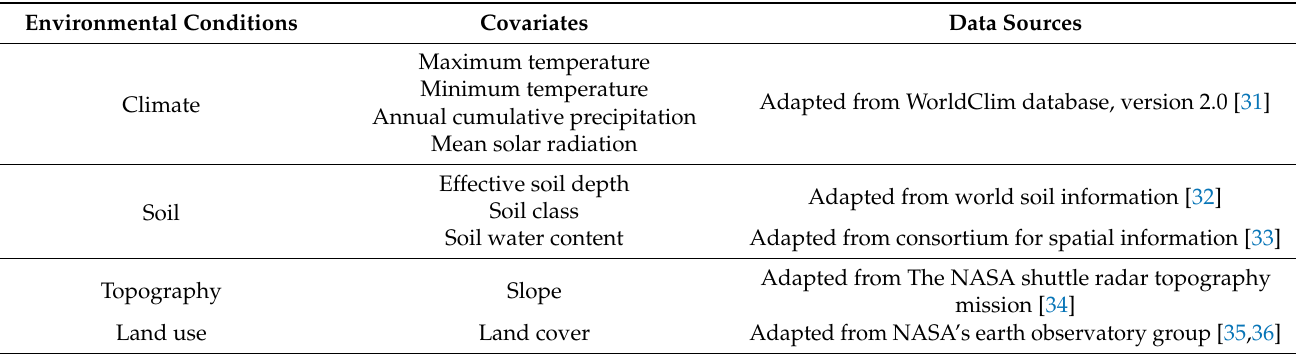
Table 1. The covariates in this